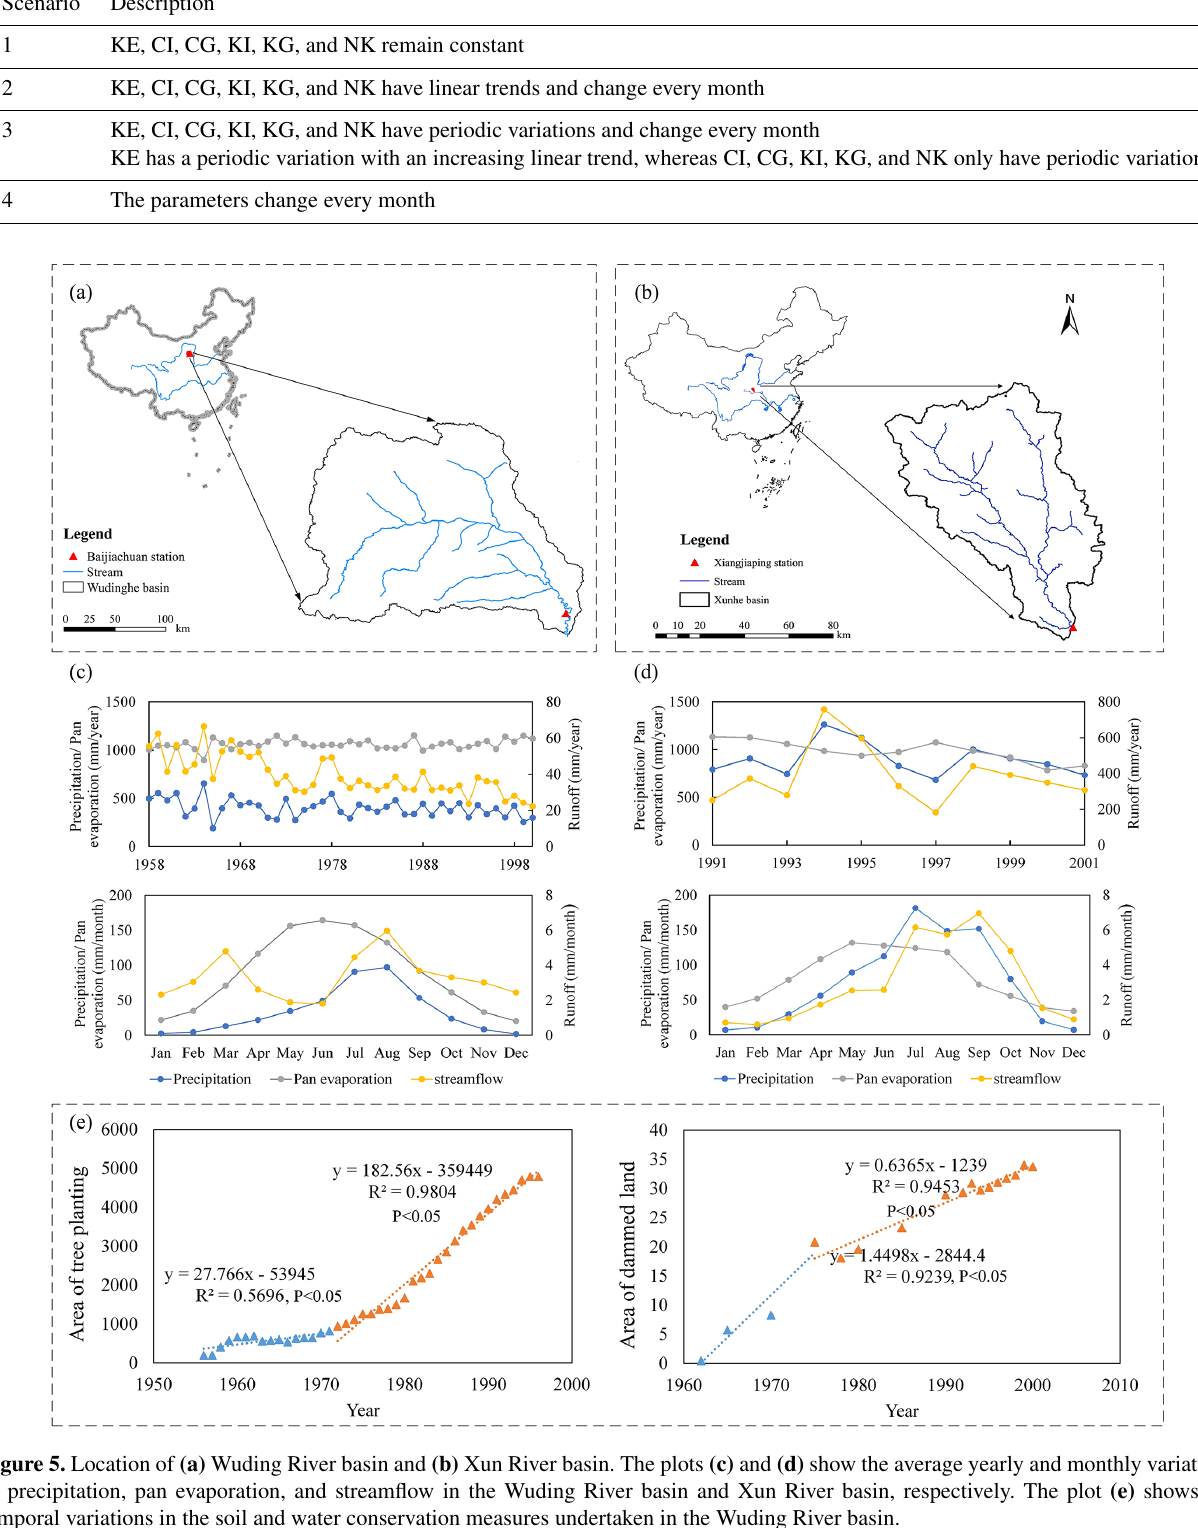
Figure 5. Location of (a) Wuding River basin and (b) Xun River basin. The plots (c) and (d) show the average yearly and monthly variations of precipitation, pan evaporation, and streamflow in the Wuding River basin and Xun River basin, respectively. The plot (e) shows the temporal variations in the soil and water conservation measures undertaken in the Wuding River